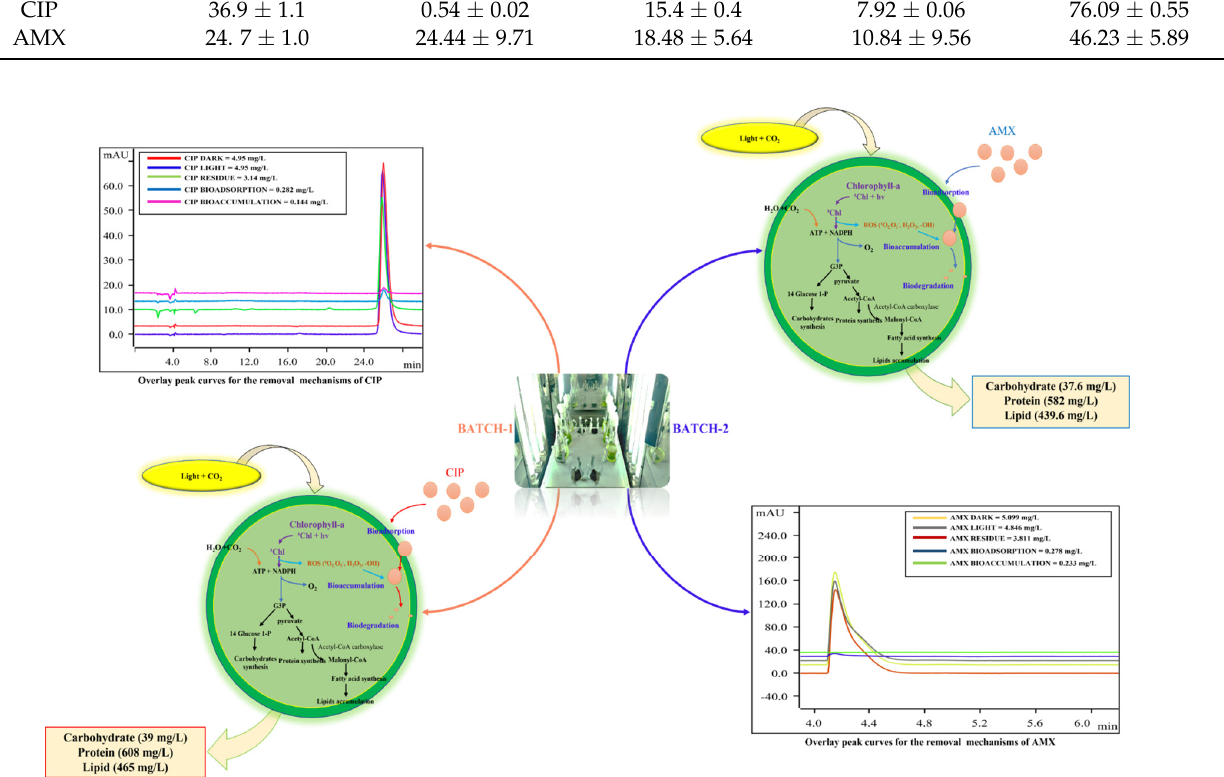
Figure 3. Removal mechanisms adopted by algae for their growth and their effects on lipids, carbohydrates, and